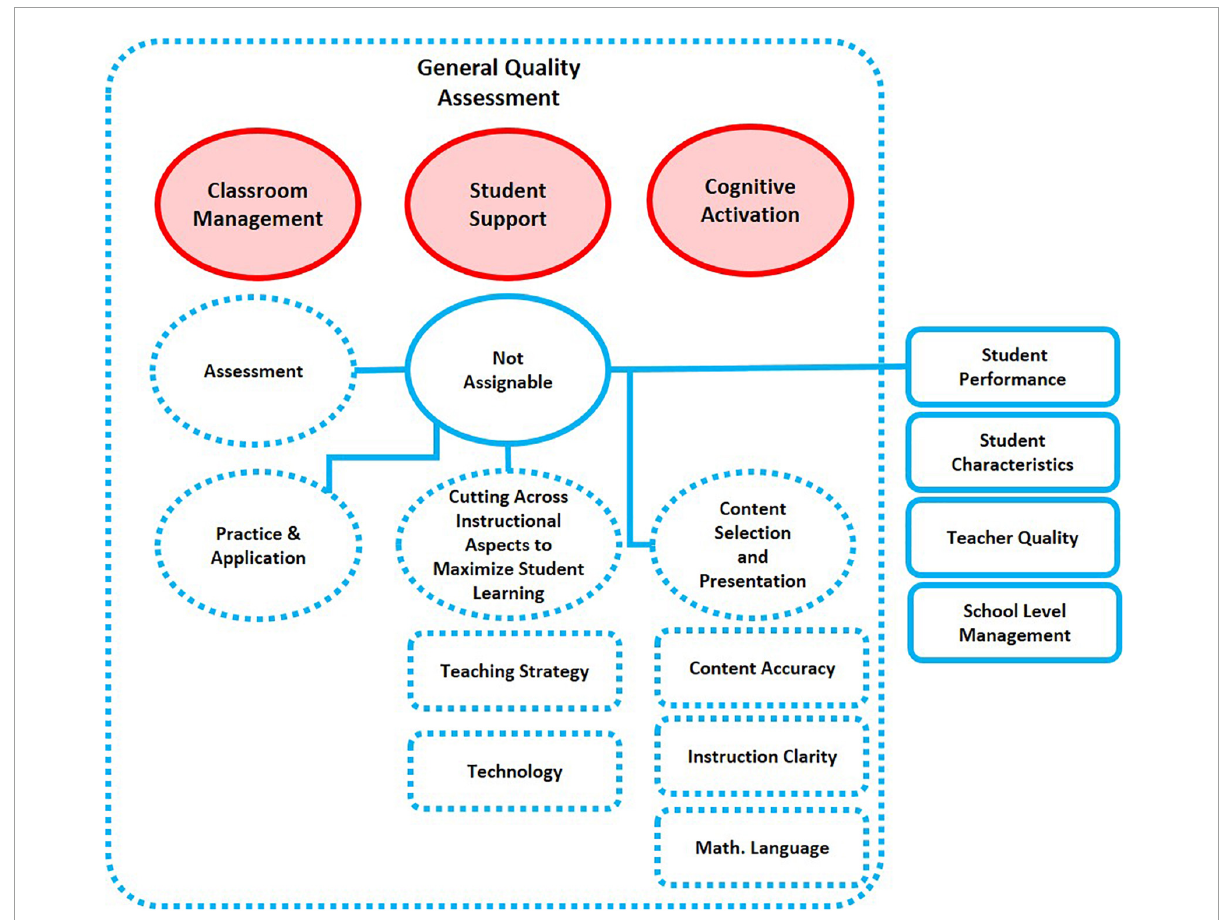
FIGURE6 Suggested adjustments on the overall measurement framework according to the comparison between conceptual indicators and empirical measurement